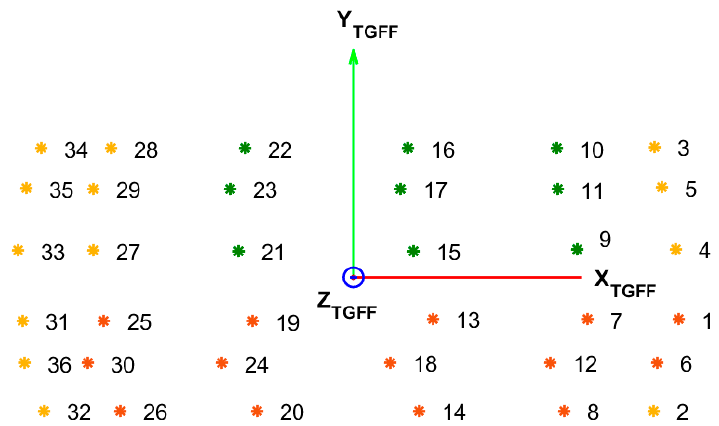
Figure 22. Qualitative representation of the locations of the Sun in TROF for test cases E-S1 to E-S36 ( z TGFF exits the figure’s plane) and their results. In green: cases in which the camera correctly detects all markers at each timestep. In yellow: cases in which part of the markers are lost from a certain timestep. In red: cases in which all the markers are lost from a certain timestep.